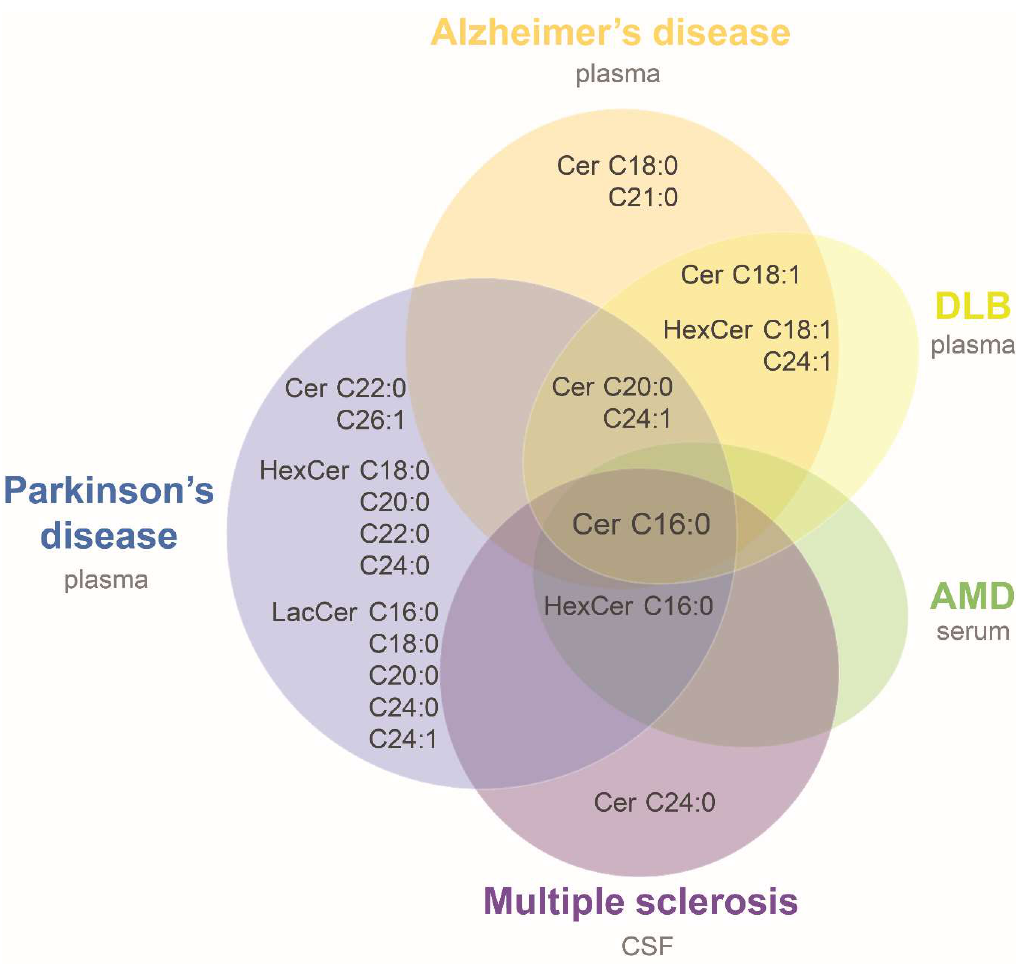
Figure 3. Ceramides increased in biofluids of neurodegenerative diseases. Venn diagram showing ceramide species found elevated in biofluids of patients suffering from neurodegenerative diseases compared to controls. Overlapping areas indicate species commonly altered among groups. Notation of ceramide species was simplified for the diagram (e.g., Cer C16:0 represents d18:1/16:0 ceramide). AMD: age-related macular degeneration; CSF: cerebrospinal fluid; DLB: dementia with Lewy bodies.